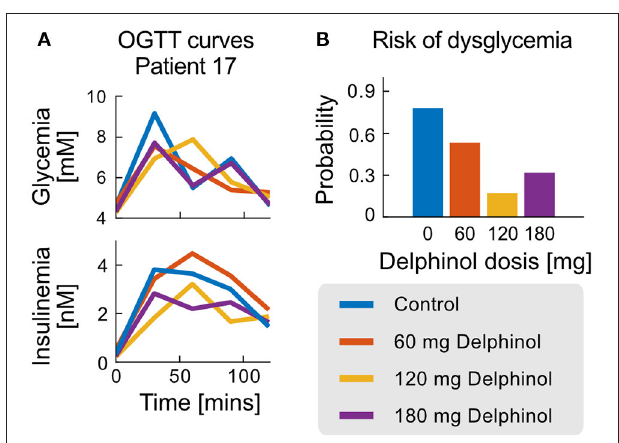
FIGURE 6 | OGTT and probability of non-health status for the case of patient 17. (A) Glycemia and Insulinemia curves for the control experiment (no Delphinol ® ) and three preprandial doses (60, 120, and 180 mg). (B) Risk of non-health status calculated from the simple logistic model for patient 17 for the control experiment and the three different Delphinol ® doses.